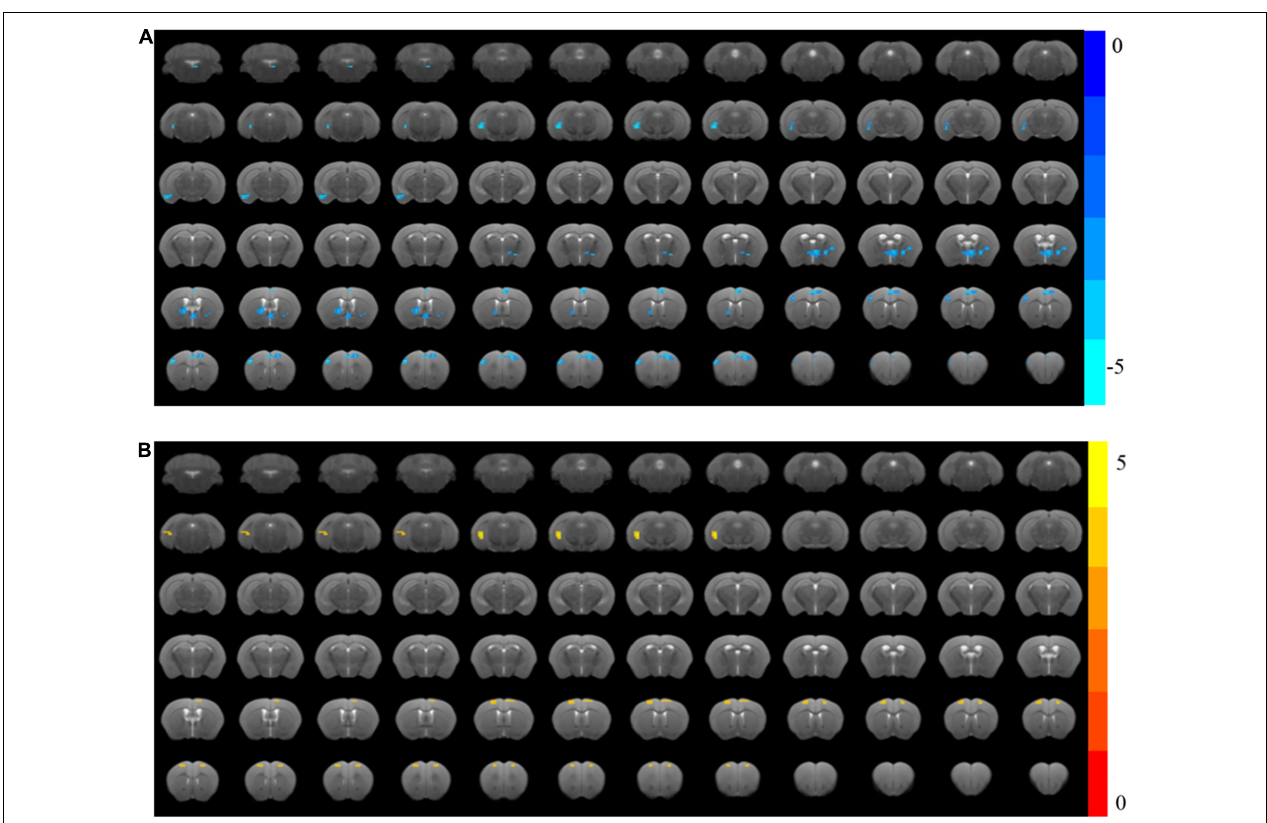
FIGURE 4 | Changes in brain functional activity after cognitive training in APP/PS1 mice. (A) The ReHo value of the AD group decreased significantly compared with the WT group. (B) The ReHo value of the Cog-group increased compared with the AD